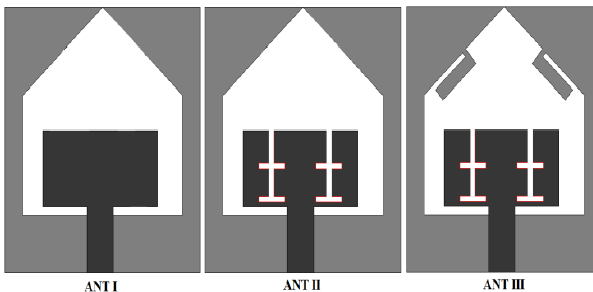
Figure 2: The structures of the proposed antennas. Ant I: reference antenna. Ant II: antenna with Double combined T-shaped slots only. Ant III: antenna with both loaded T- slots and rotated L-stips.